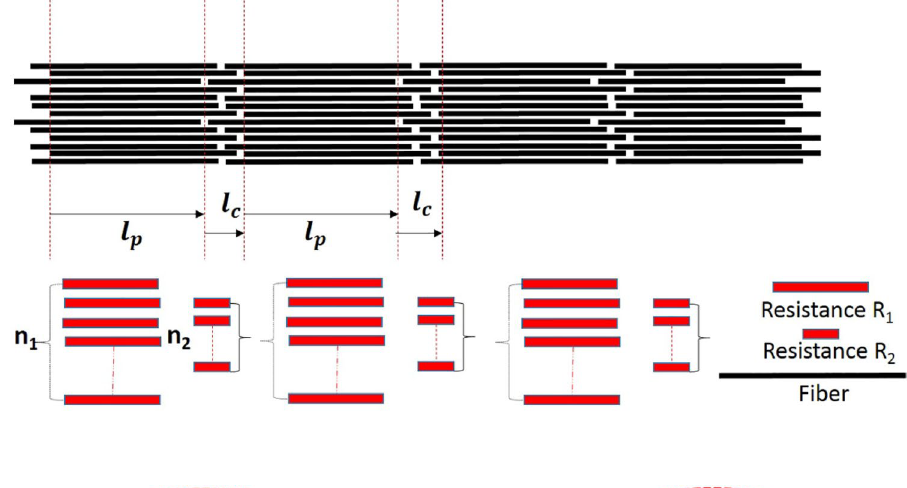
Fig. 4 Schematic diagram of radial fibers distribution: a tightly packing model, b actual